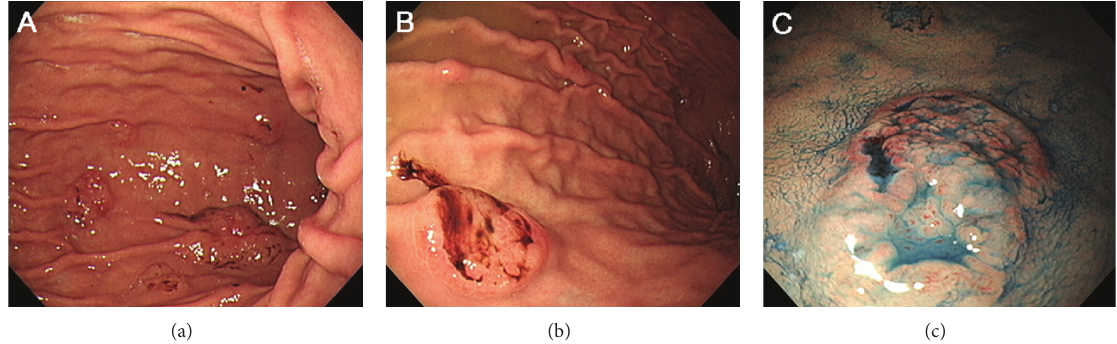
Figure 2: Endoscopic images of the stomach. Multiple flat elevated lesions with irregular and fragile mucosa are shown. Some of them had spontaneous bleeding (a, b). Indigo carmine contrast spray emphasized the irregular mucosa